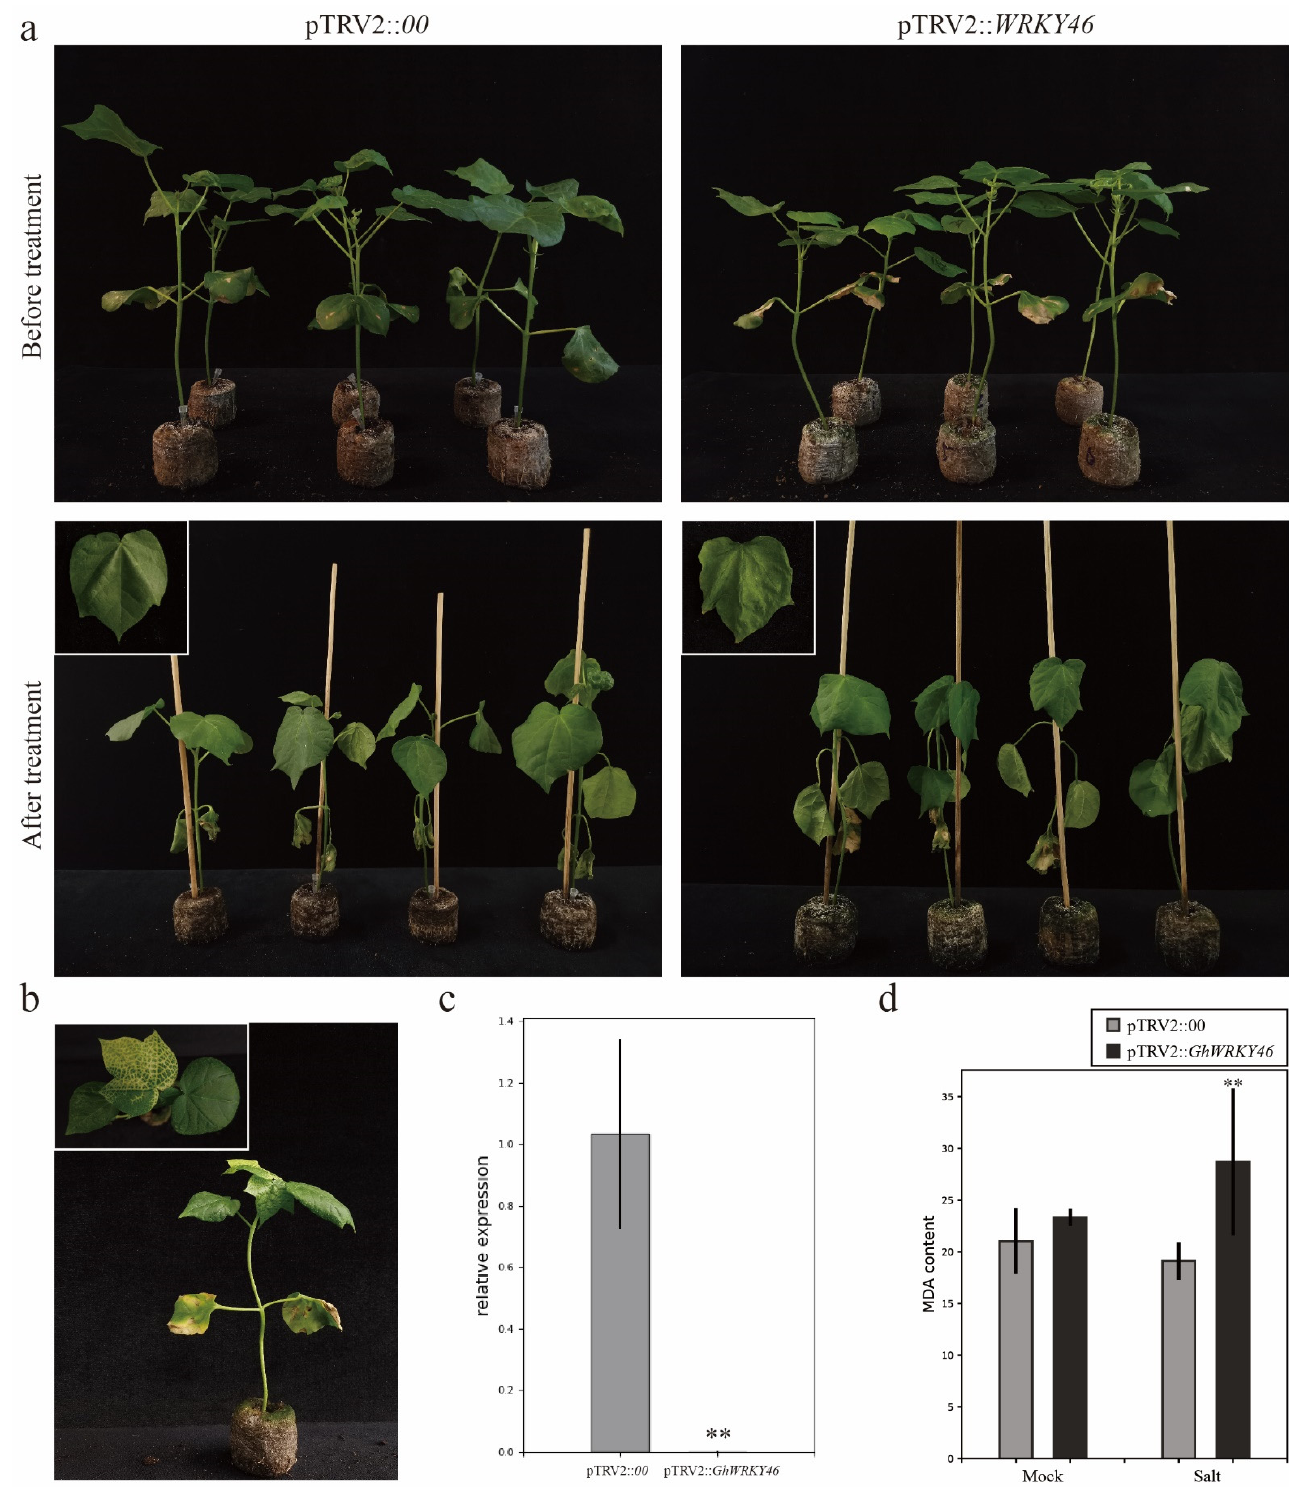
Figure 7. Silencing GhWRKY46 via VIGS decreases salt tolerance in cotton. ( a ), Phenotype of pTRV2:: GhWRKY46 plants under 400 mM NaCl treatment. ( b ), Albino phenotype after pTRV2:: CLA1 silencing. ( c ), Relative expression of GhWRKY46 in pTRV2:: 00 and silencing pTRV2:: GhWRKY46 plants via qRT-PCR analysis. ( d ), The MDA content of pTRV2:: 00 and pTRV2:: GhWRKY46 after salinity stress. Error bars represent the standard deviation of three independent biological replicates (** p < 0.01 Student’s t -test).